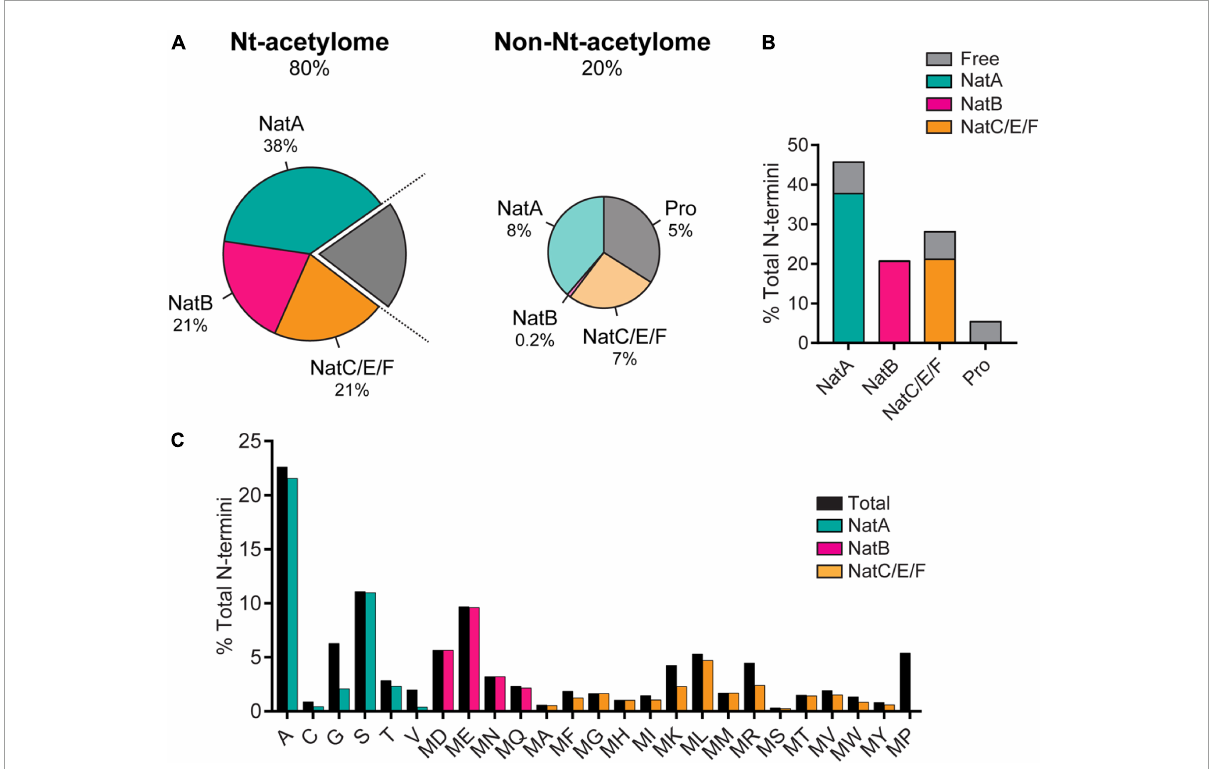
FIGURE1 (A) The prevalence of N-terminal acetylation in human cells is depicted by separating the proteome into the N-terminal(Nt)-acetylome (80%) and the non-Nt-acetylome (20%). The human Nt-acetylome (the complete set of N-terminal acetylated proteins) was predicted by incorporating experimentally determined Nt-acetylation events (including NatC and NatF related data) to all SwissProt entries (version 57.8) based on the occurrence of the first two amino acids. The chance that a protein will be Nt-acetylated mainly depends on the identity of the first two amino acids. To visualize this concept, the Nt-acetylome can be grouped according to (B) NAT substrate class or (C) N-terminal amino acid frequency. NatD is not depicted due to its limited coverage. Image reproduced from Ree et al. (2018) licensed under CC BY 4.0. The figure legend is a modified excerpt of the